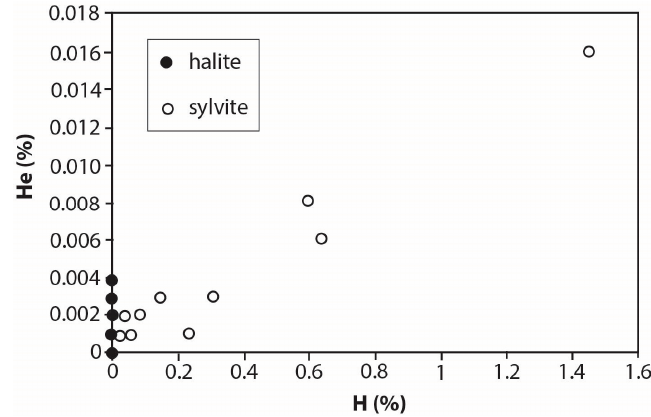
Figure 3. Cross-plot of concentrations of hydrogen (%) and helium (%) in volatiles released by cold-crushing of sylvite and halite samples (data in Table 1). Table 1. Composition of volatiles released by cold-crushing samples of sylvite and halite from Boulby mine, and Eskdale No. 2 borehole.